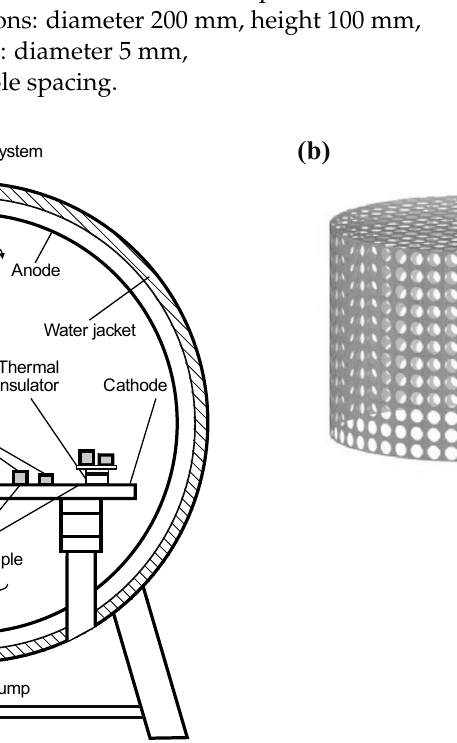
Figure 1. Diagram of a modified glow discharge nitriding device with a visible active screen: ( a ) diagram of the JON-600 furnace, ( b ) active screen.